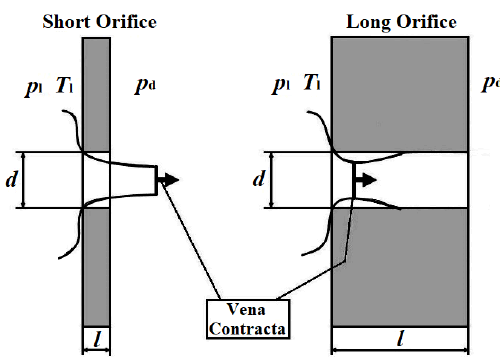
Figure 9. Illustration of sharp-edged orifice jet and nozzle jet.